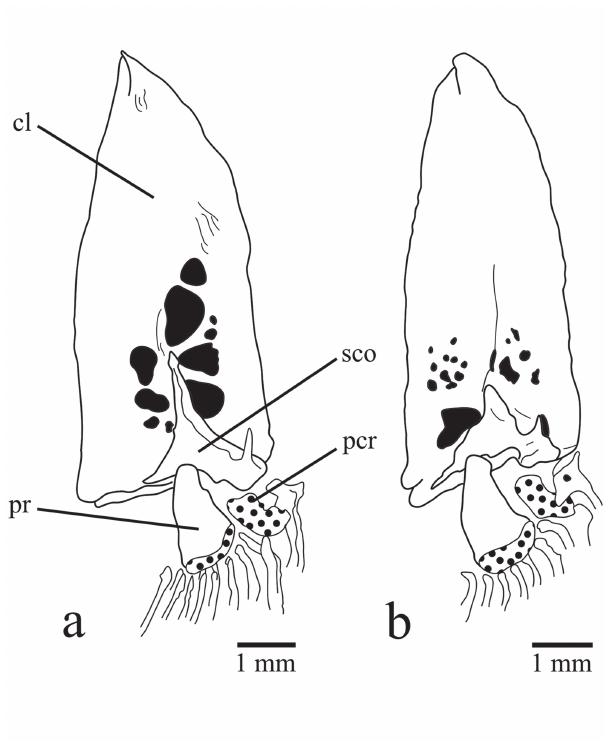
Fig. 1. Pectoral girdle of: a. Trichomycterus steindachneri (MBUCV-V-35652), paratype, 86.7 mm SL. b. T. cachiraensis (MBUCV-V-35384), paratype, 74.9 mm SL. Ventral view. Abbreviations: cl, cleithrum; pcr, pectoral complex radial; pr, pectoral radial; sco,